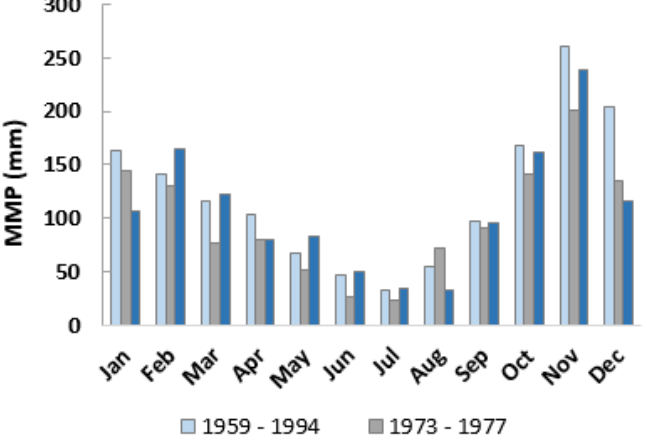
Figure 3. Mean Monthly Precipitation (MMP) seasonal trend in the study area, based on [26].